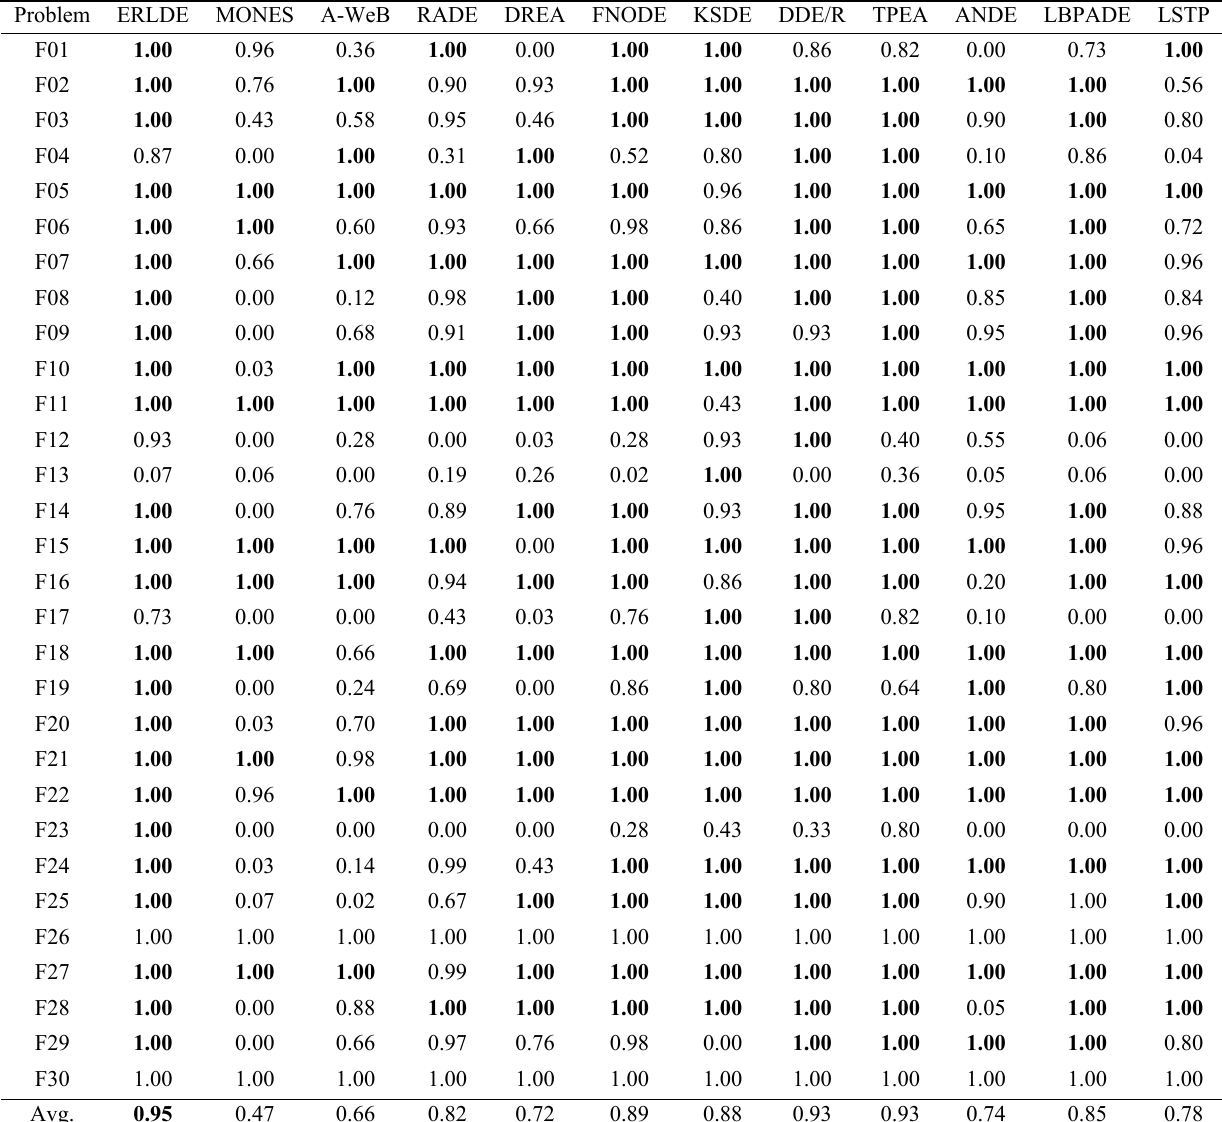
Table A3 Comparison between ERLDE and other algorithm with respect to SR